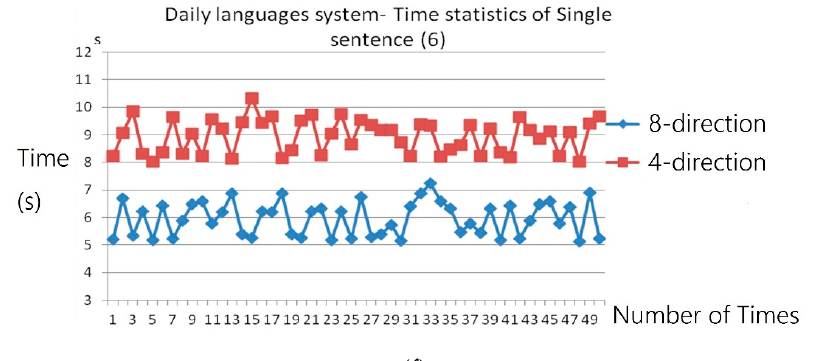
Figure 10. The test results of the frequently used Chinese numeric sentences table with head-control interface ( a ) user #1 ( b ) user #2 ( c ) user #3 ( d ) user #4 ( e ) user #5 ( f ) user #6.